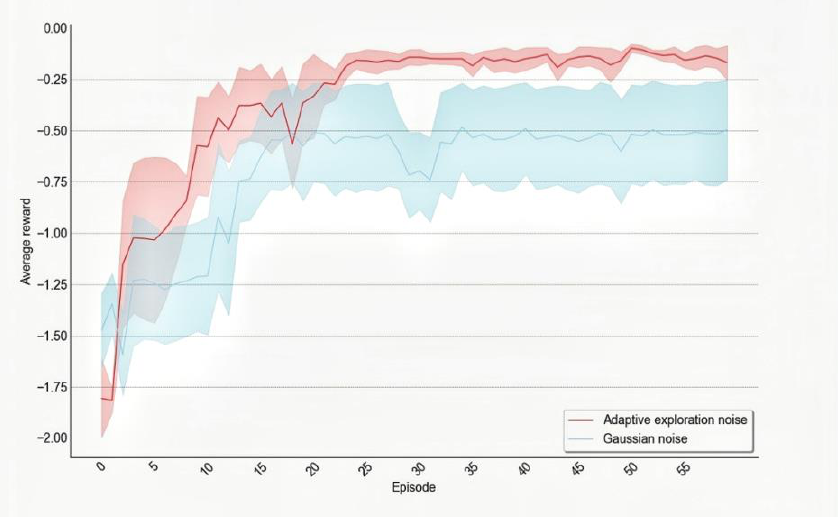
Figure 17. The change in the average reward of the longitudinal trajectory tracking task with the number of training